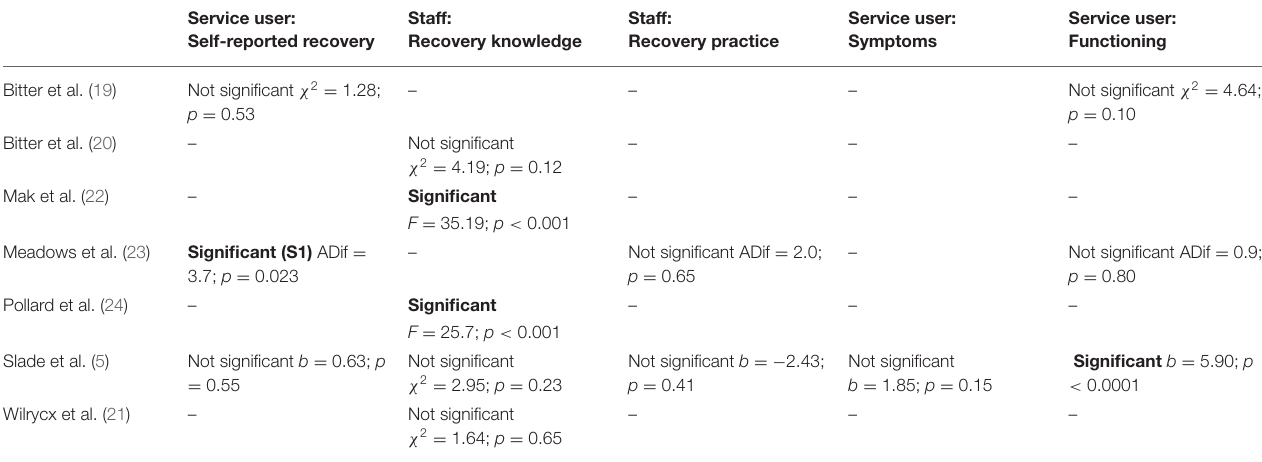
TABLE 4 | Summary of effectiveness data, across outcome variables (group x time effects, unless otherwise indicated). Service user: Self-reported